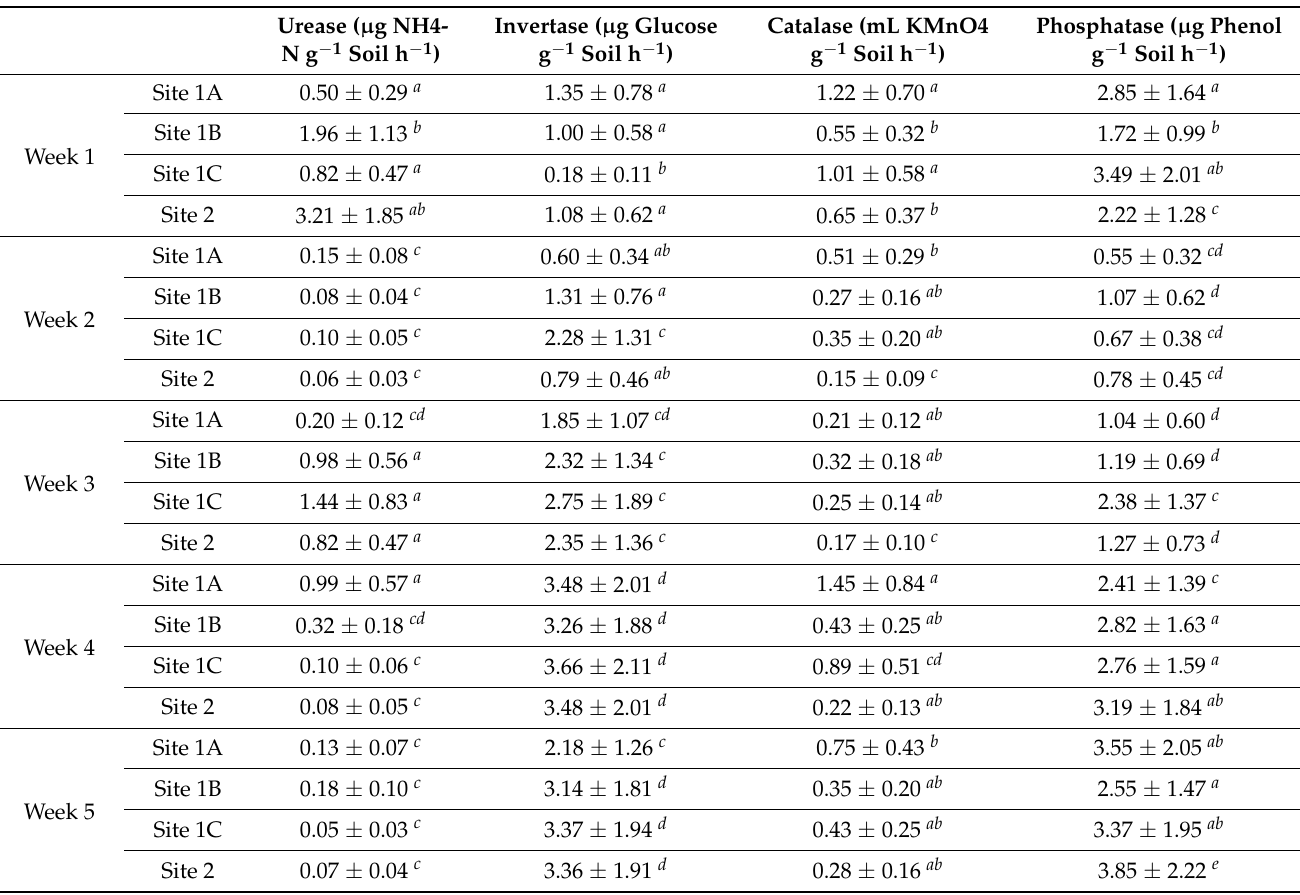
Table 2. The results of enzyme assay in soil